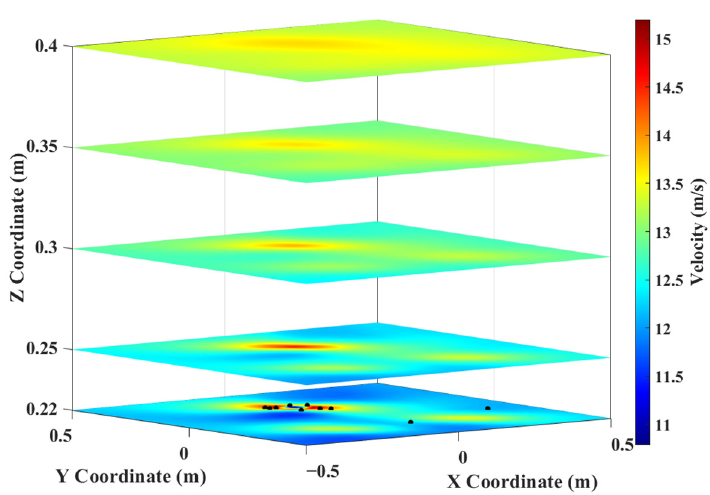
Figure 21. Reconstructed velocity nephograms with optimal sensor locations (Boundary Condition 2).